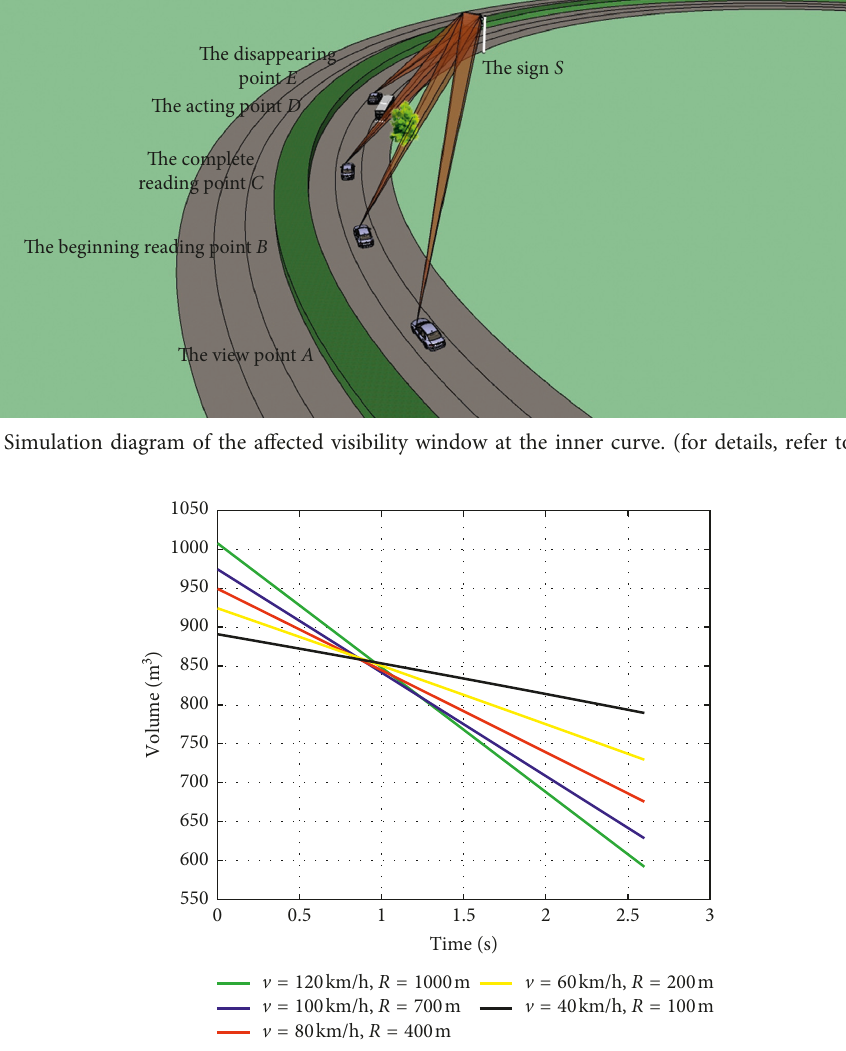
Figure 8: The volume of visibility window as function of speed on the outer curved highway (for details, refer to the text).